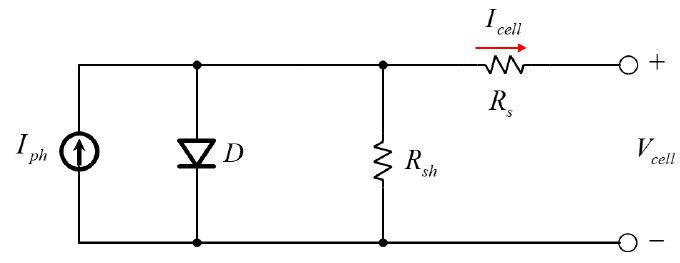
Figure 1. The equivalent circuit of a photovoltaic (PV) cell.